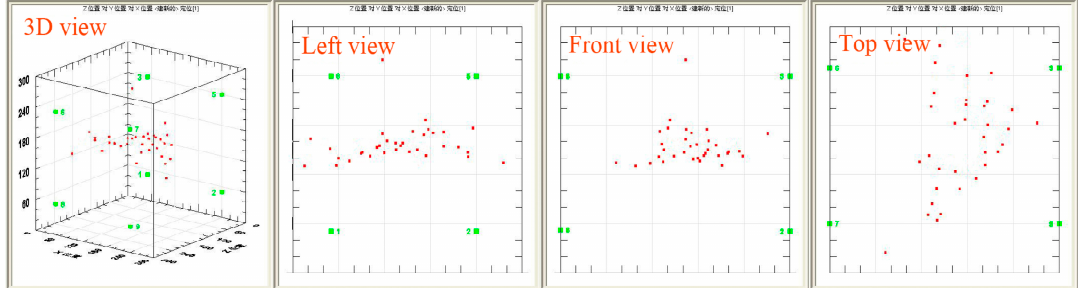
Figure 16. Spatial arrangement of acoustic emission events in the four-branched tree-type borehole hydraulic fracturing model.